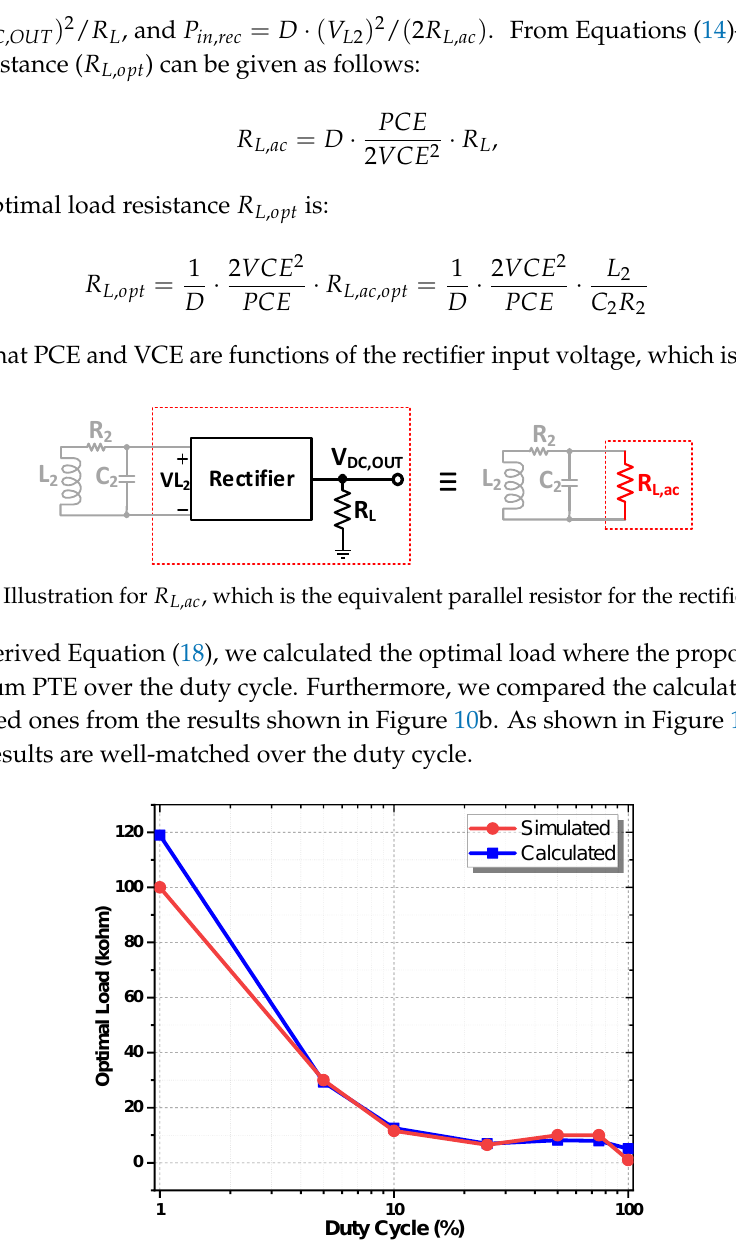
Figure 12. Simulated and calculated optimized load conditions for the maximum PTE over the duty